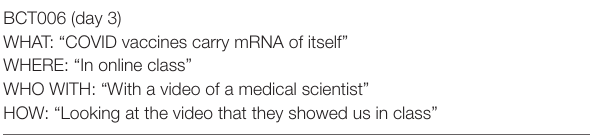
WHERE? “At home, looking at the television news” WHO WITH? “TV3 news”